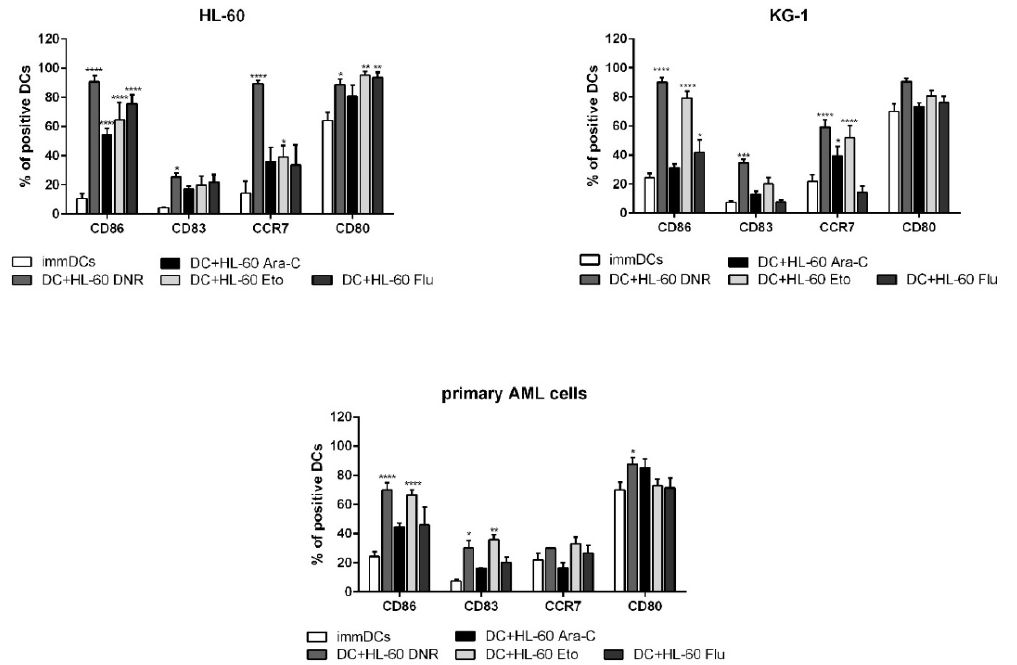
Figure 6. Flow cytometry analysis of dendritic cell (DC) maturation mediated by HL-60, KG-1 and primary AML cells treated with chemotherapy. The HL-60, KG-1 and primary AML cells were treated with daunorubicin (DNR) (500 ng/mL), cytarabine (Ara-C) (20 µg/mL), etoposide (Eto) (20 µg/mL) and fludarabine (Flu) (70 µg/mL) for 4 h and loaded in immature (imm) DCs for another 20 h. The DC phenotype was evaluated by flow cytometry. Un-loaded immature immDCs were used as a negative control. The values are represented as mean ± SEM of 5/3/3 independent experiments for HL-60/KG-1/primary AML cells, respectively. * p < 0.05; ** p < 0.01; *** p < 0.001; **** p < 0.0001 compared to immDCs.